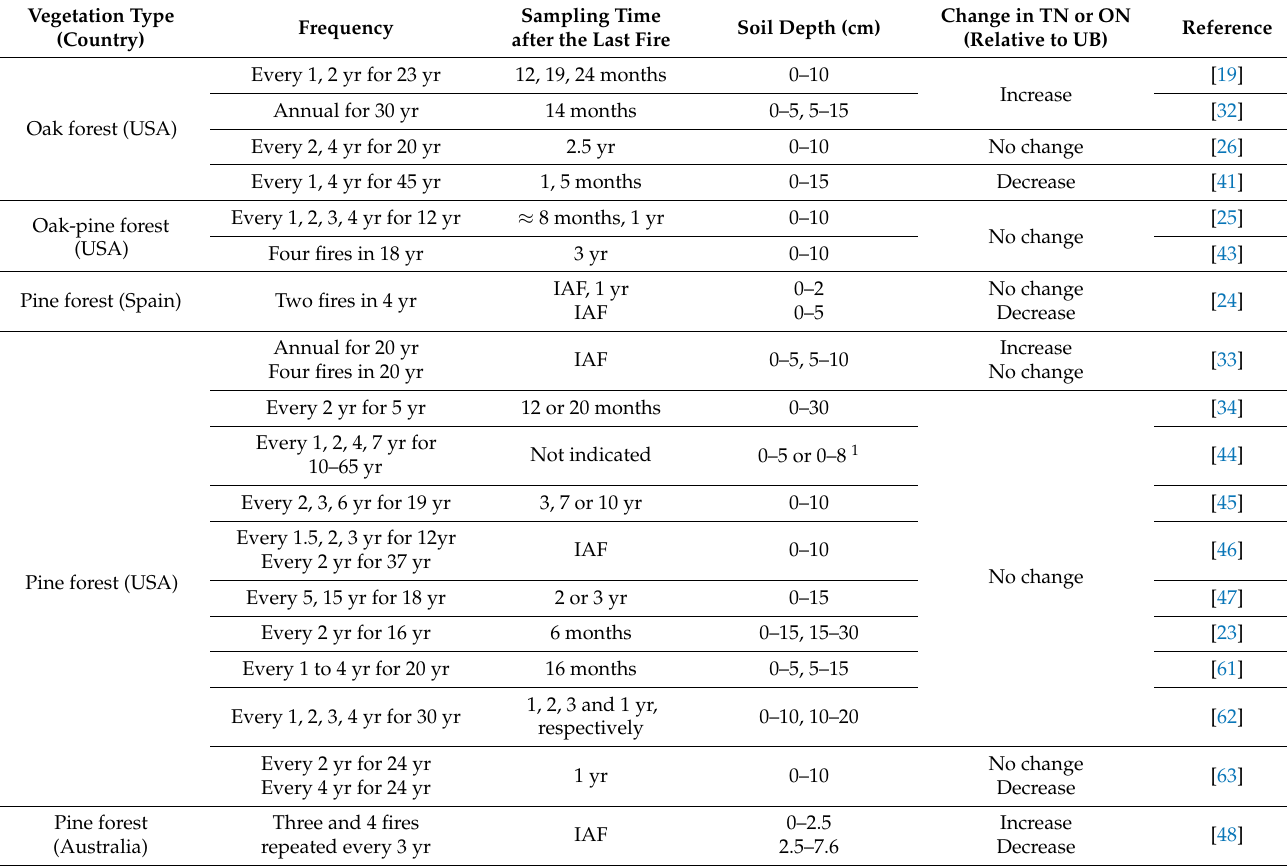
Table 3. Studies including the effects of repeated prescribed fires on total or organic nitrogen (TN, ON). UB: unburned soil; yr: year; IAF: immediately after